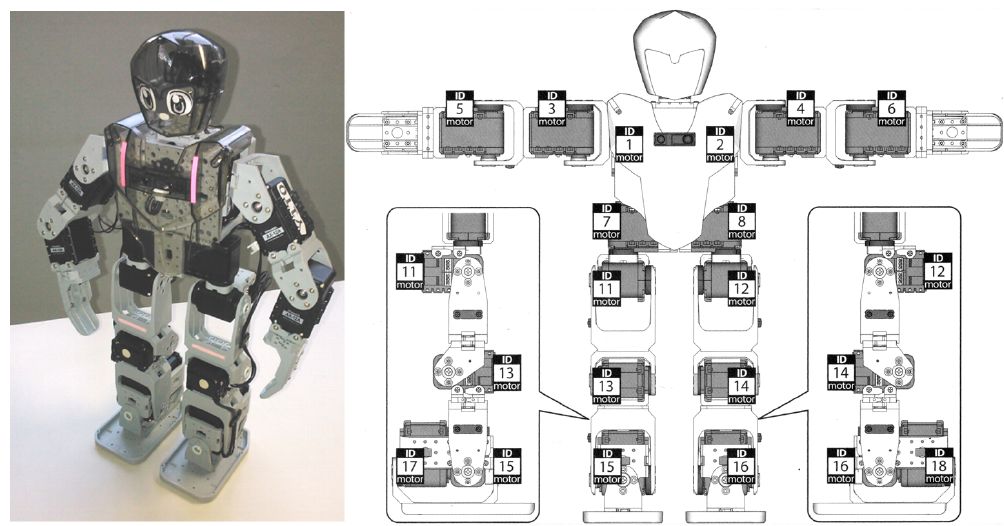
Figure 1. Dynamixel array (dyn1–8, dyn11–18) of the B-Type humanoid